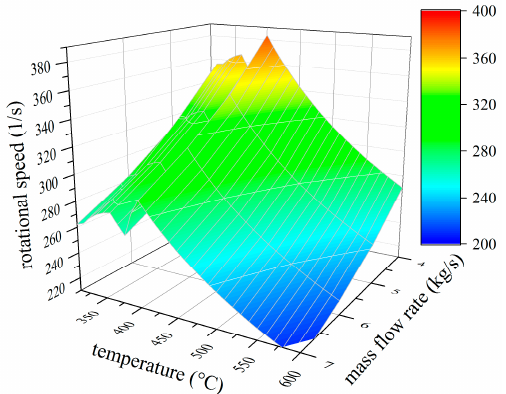
Figure 10. Heat exchanger area of hexamethyldisiloxane depending on heat source temperature and mass flow rate.